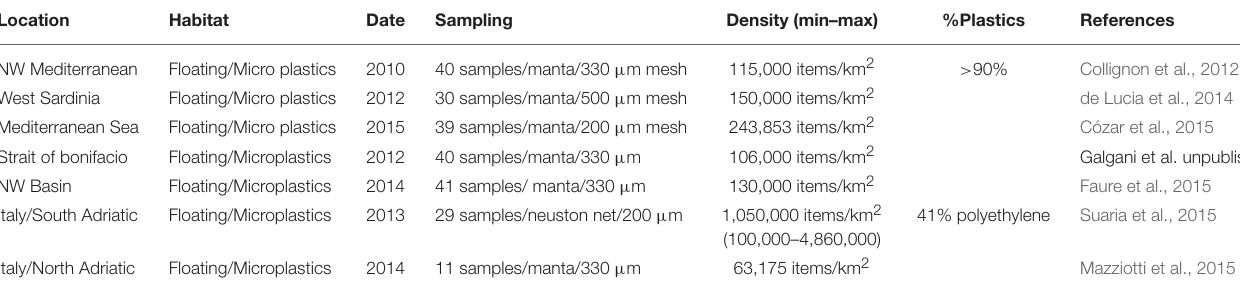
TABLE 2 | Summary of some available data for microplastics in surface waters in the Mediterranean Sea.